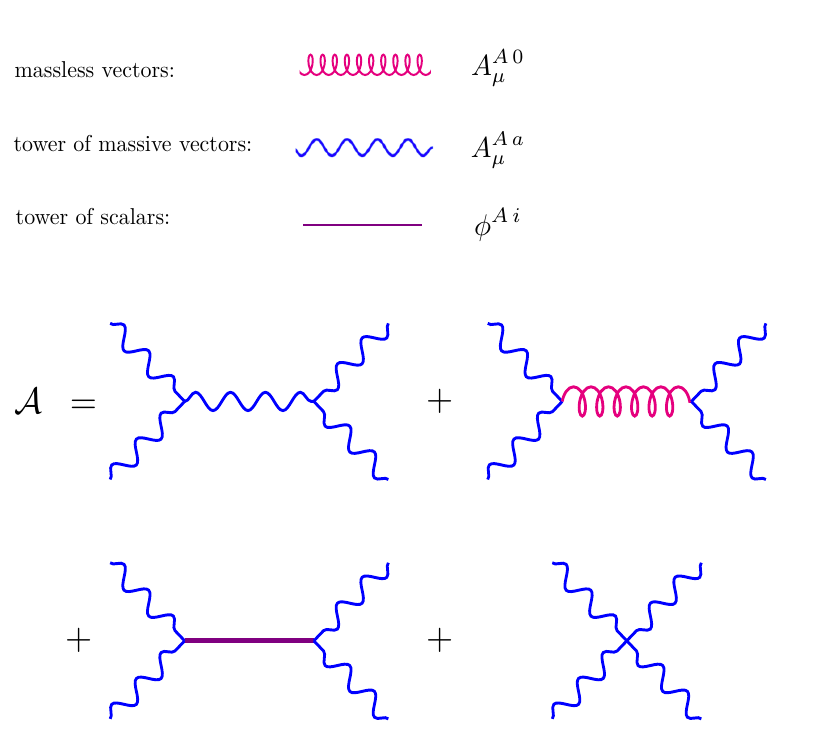
Figure 2 . The spectrum of a YM theory KK reduced on a general manifold and a schematic representation of the four-point tree-level massive vector